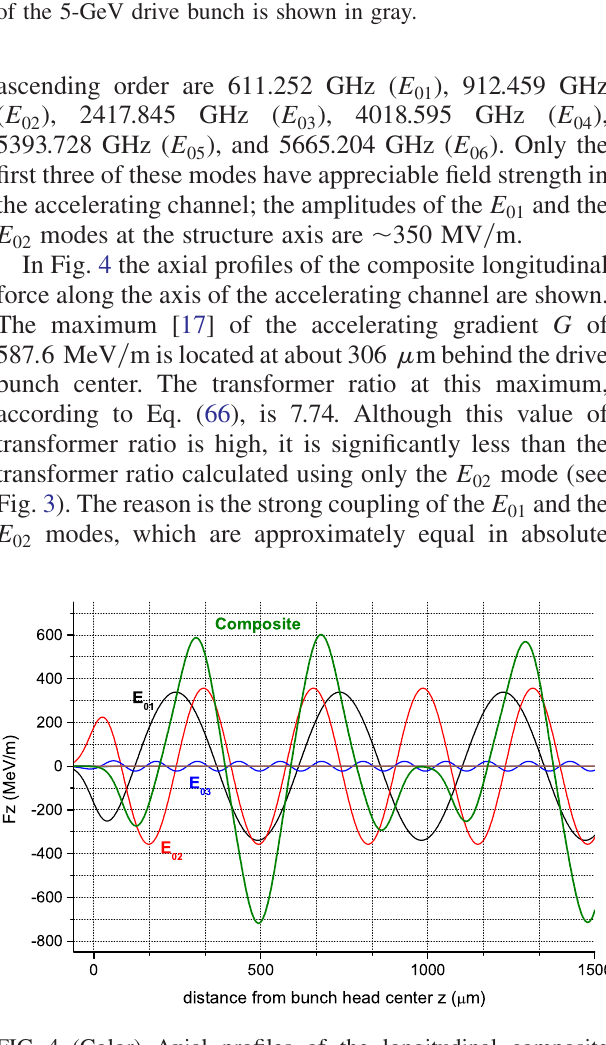
modes acting on 0 m